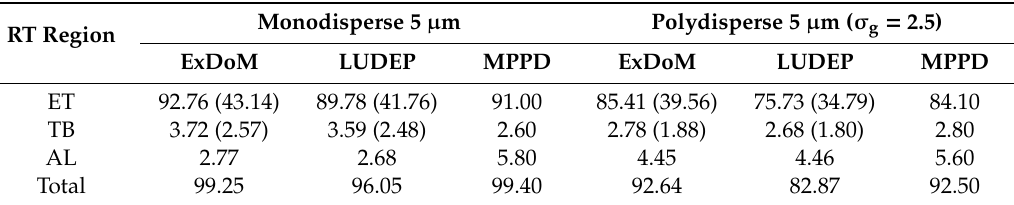
Table 1. Local deposition fraction (%) of 5 µ m monodisperse and polydisperse ( σ g = 2.5) aerosol from the ExDoM compared with the Lung Dose Evaluation Program (LUDEP) and Multiple-Path Particle Dosimetry (MPPD) models. Reprinted with permission from [39]. Copyright 2013,